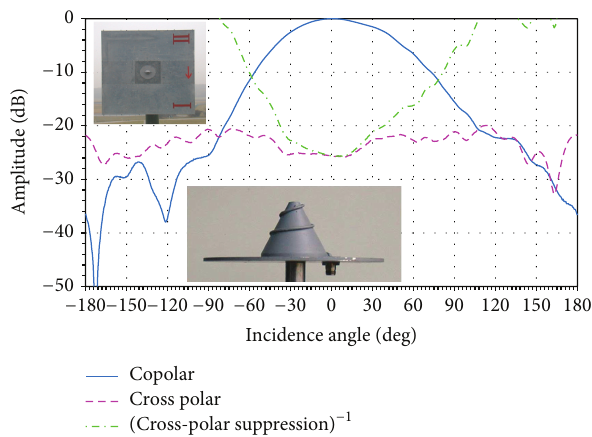
Figure 3: Normalized receive antenna pattern at the measurement center frequency of 1.51 GHz.